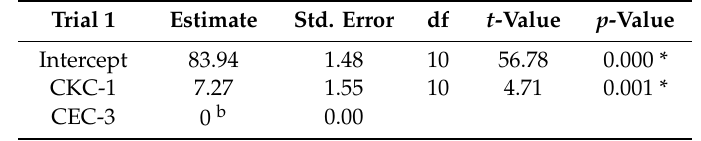
Table 14. The significant di ff erence of mean scores obtained in Trial 1 between CKC-1 and CEC-3. Trial 1 Estimate Std. Error df t -Value p -Value Intercept 83.94